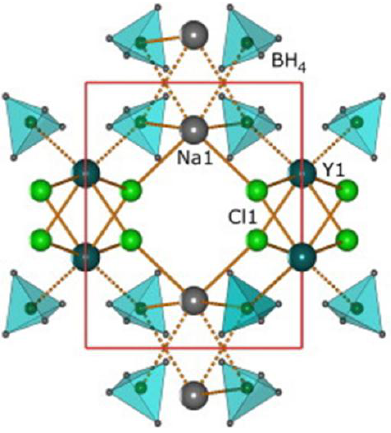
Figure 11. Crystal structure of NaY(BH 4 ) 2 Cl 2 at T ~ 230 °C [79]. Reprinted from [79] with permission from the International Association of Hydrogen